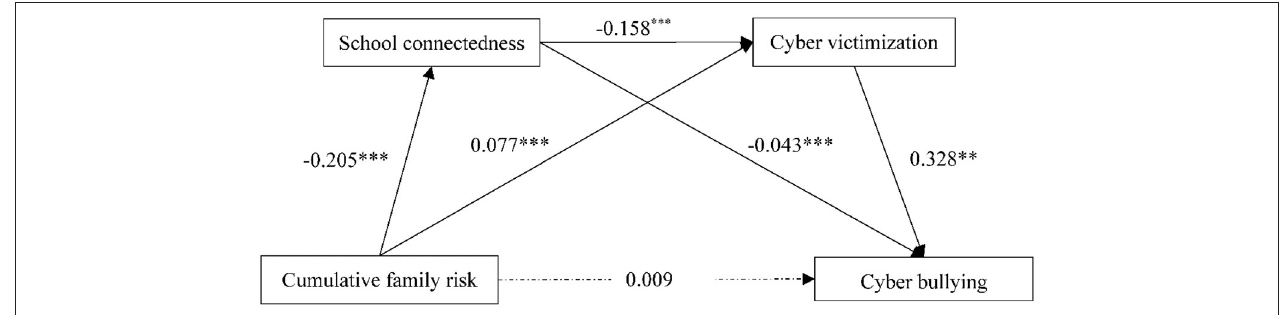
FIGURE 2 | The chain mediating effect of school connectedness and cyber victimization. ** p < 0.01, *** p <